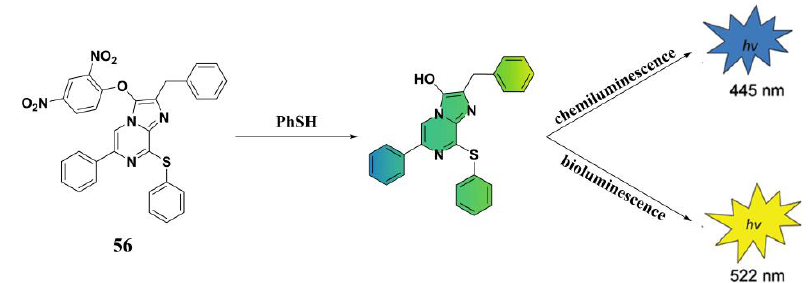
Figure 23. The chemiluminescent and bioluminescent sensing of probe 56 for PhSH.